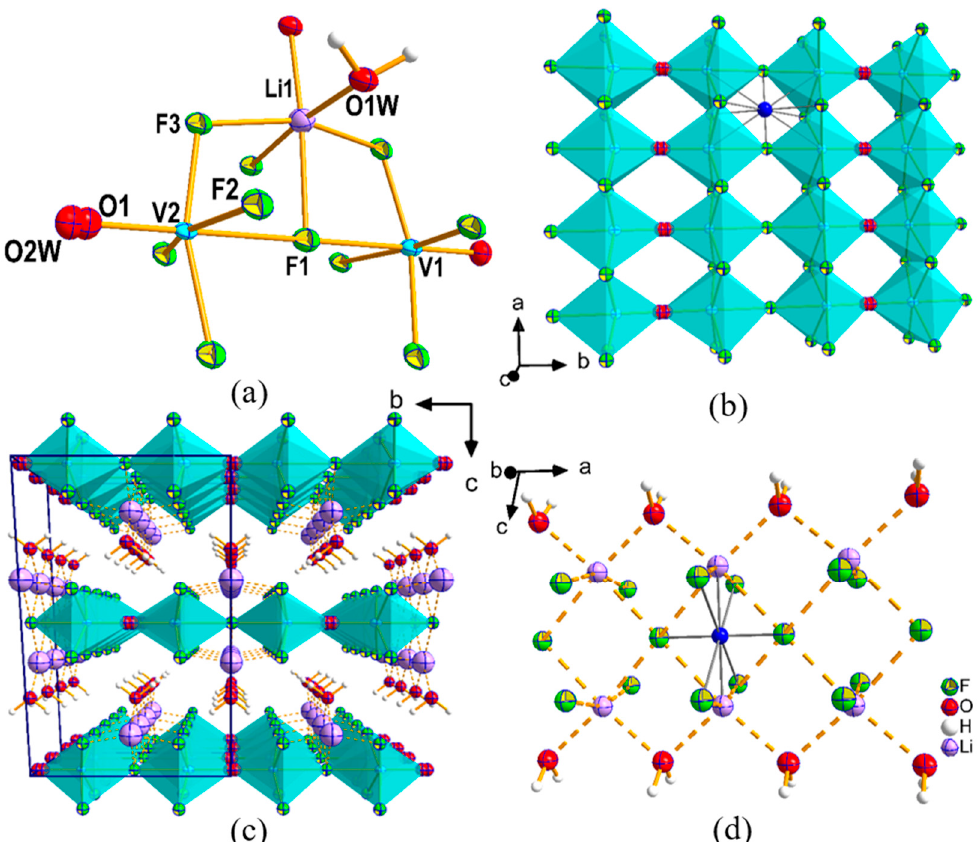
Figure 2. ( a ) Coordination of different atoms in I is shown. Only atoms that appeared in asymmetric unit are labeled. Thermal ellipsoids are given at 50% probability. ( b ) The center of inversion within the ribbon is shown with a blue dummy atom. V-octahedra are shown with cyan color. ( c ) Stacking of layers showing the presence of Li-ions and water in the inter-layer space. ( d ) The center of inversion within the Li-centric polyhedral layers is shown with blue dummy atom.